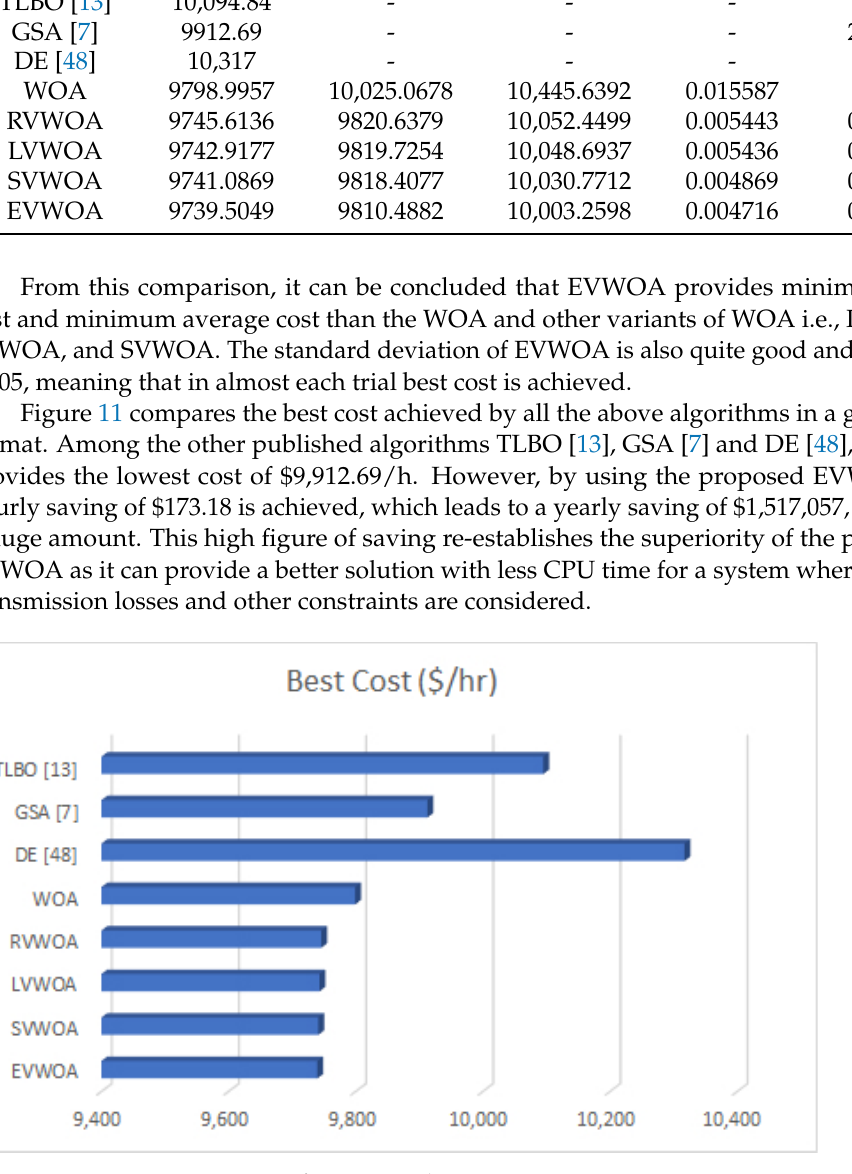
Figure 11. Best Cost Comparison for Case Study